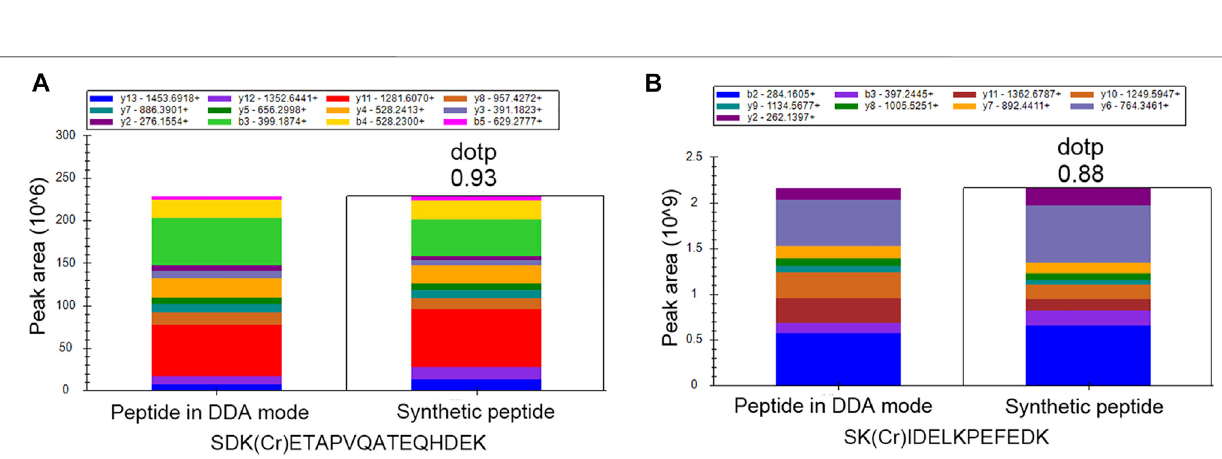
Frontiers in Genetics |